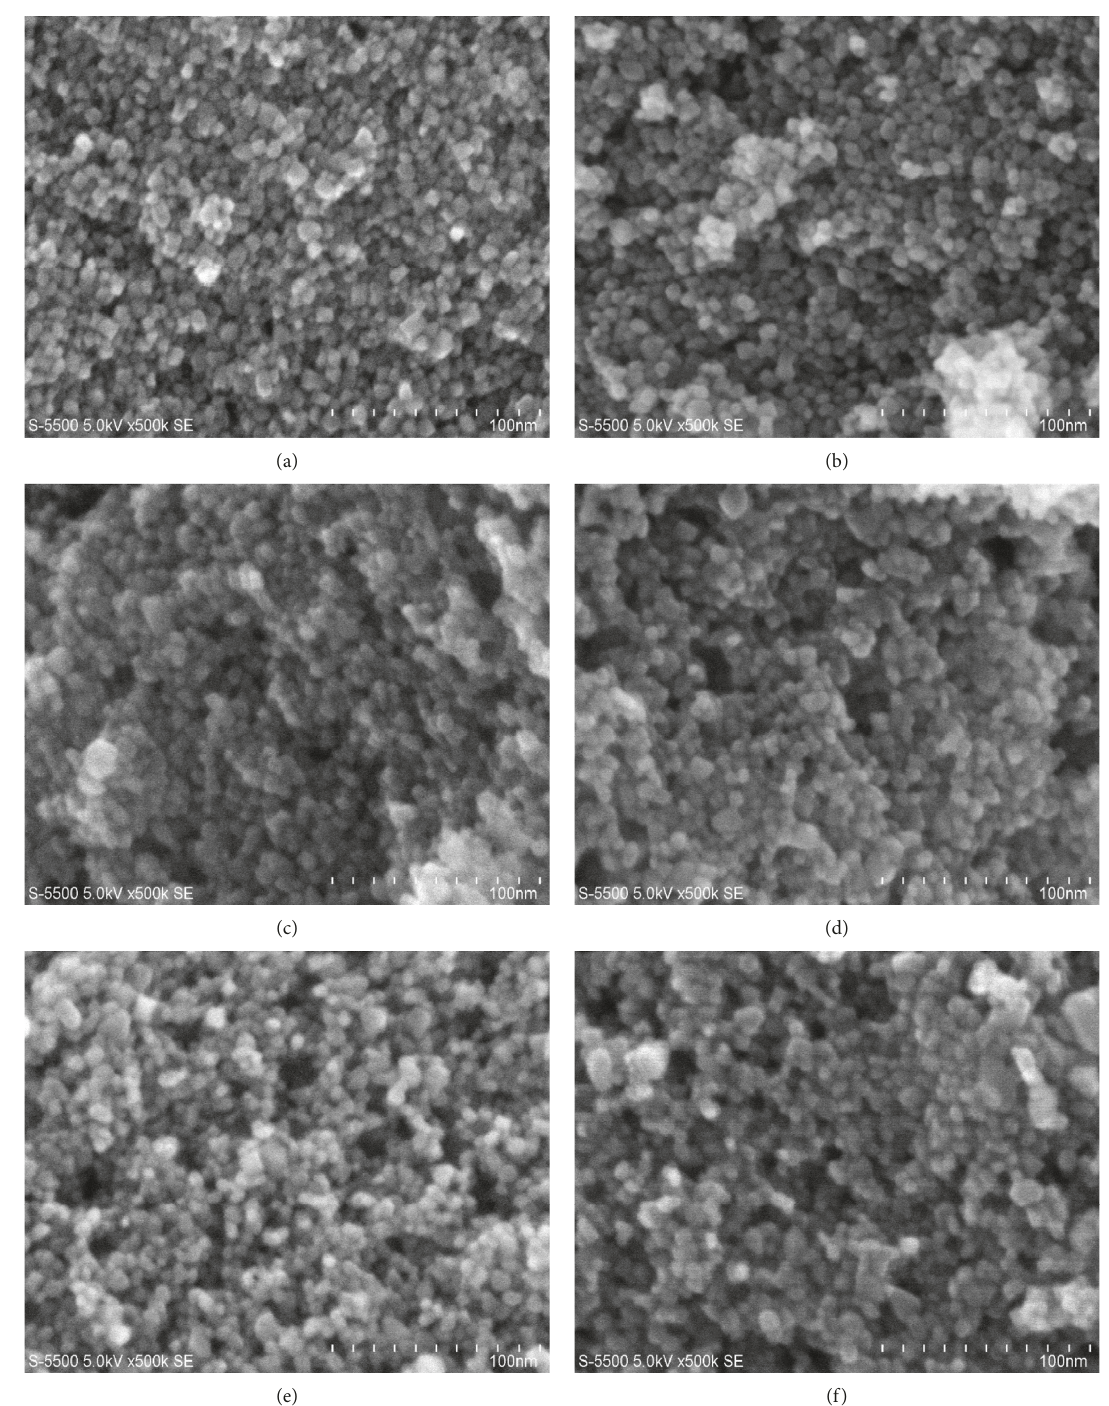
Figure 6: Micrographs (500,000X magnification) of TiO 2m synthesized at different HCl concentrations: (a) 0.5, (b) 1.0, (c) 1.5, (d) 2.0, (e) 2.5, and (f) 3.0%